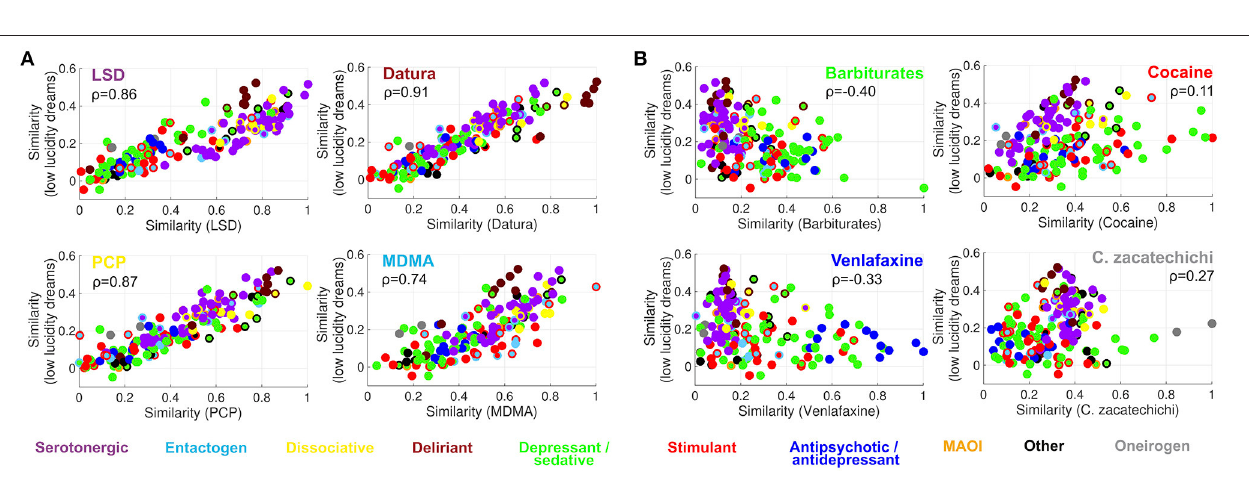
FIGURE 4 | Prediction of the similarity between the subjective report of substances and dreaming experiences of high lucidity, based on the similarity to LSD, plants of the Datura genus, PCP and MDMA (A) and to reports of barbiturates, cocaine, venlafaxine and Calea zacatechichi (B) . Substances are represented with circles that are color-coded as in Figure 1 . The inset shows the value of the Spearman’s rank correlation coefficient ( ρ ).